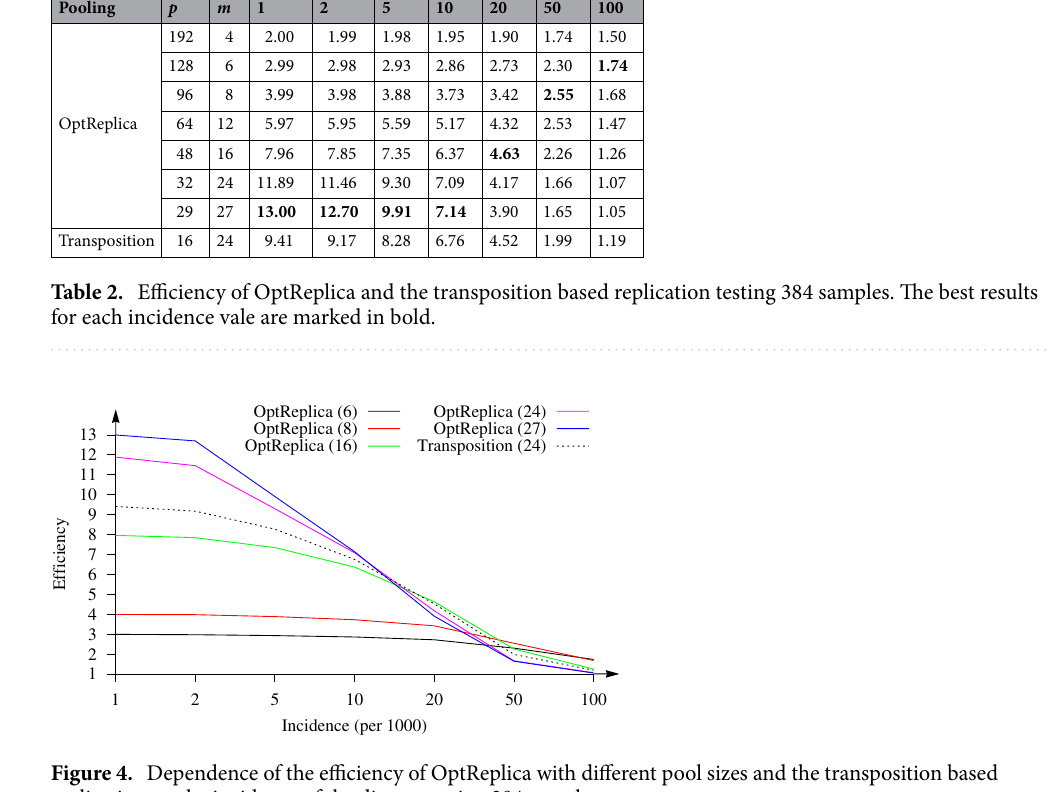
Figure 4. Dependence of the efficiency of OptReplica with different pool sizes and the transposition based replication on the incidence of the disease testing 384